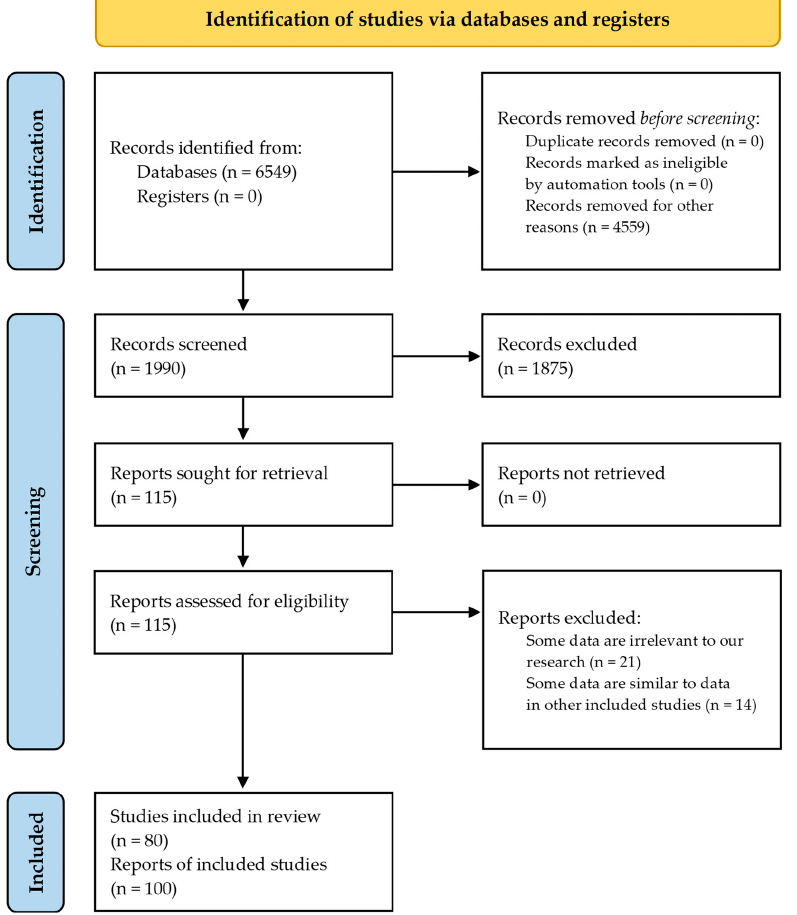
Figure 2. Methodology for literature selection according to the PRISMA 2020 flow diagram for a new systematic review that included database and registry